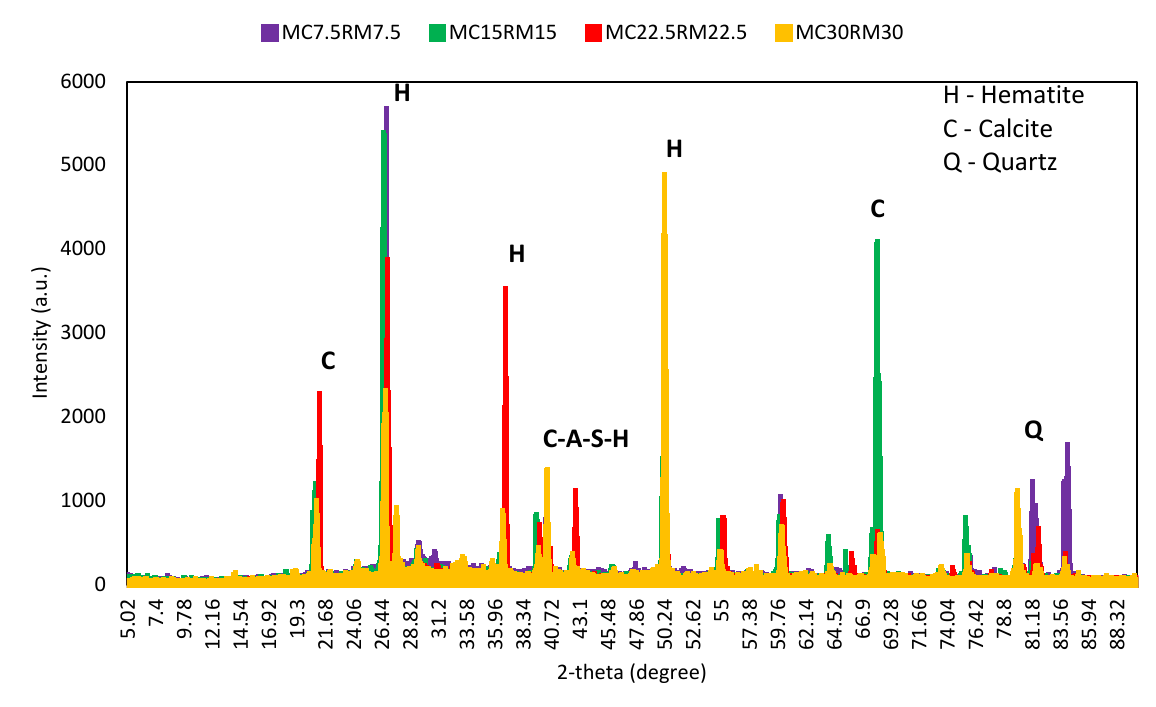
Figure 15. XRD analysis of alkali-activated samples with both DCP and RM.